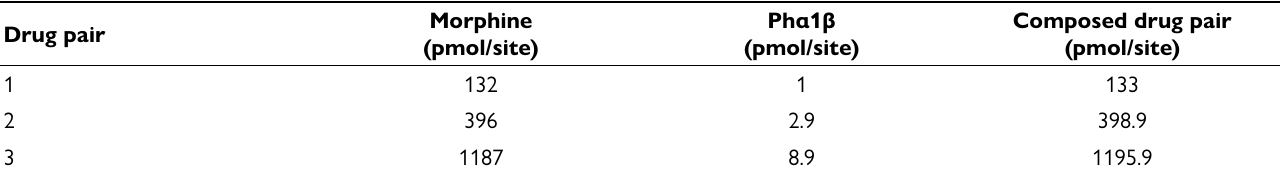
Table 2. Doses used in the dose-response curve for the joint treatment with recombinant Phα1β (i.t.) and morphine